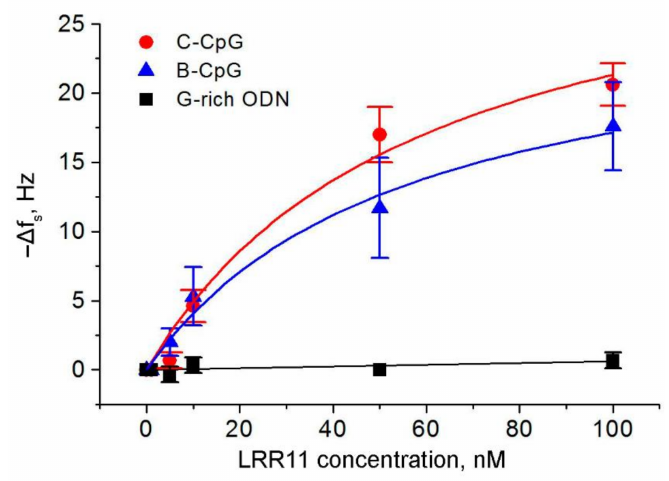
Figure 5. Plot of changes in the resonance frequency, ∆ f s , as a function of the LRR11 peptide concentration for an acoustic biosensor with immobilized 5 (cid:48) -biotinylated ODNs under investigation. The data represent mean ± SEM obtained from three independent experiments. The curves are fitted according to Equation (1) obtained with the OriginPro 7.5 (OriginLab Corporation, MA,